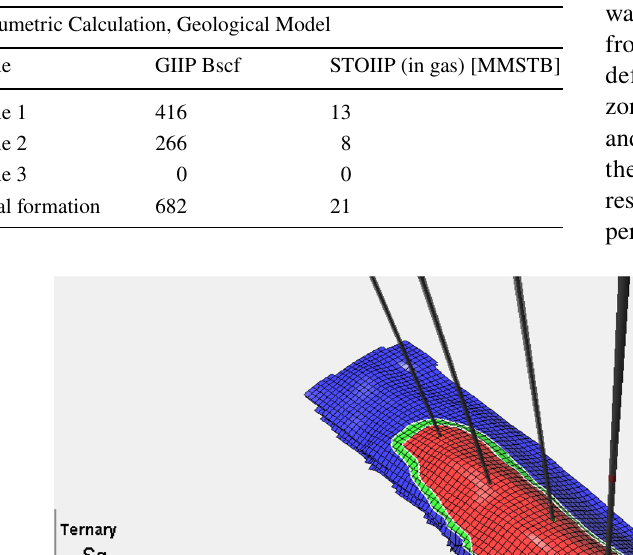
Table 2 Volumetric calculation based on static model